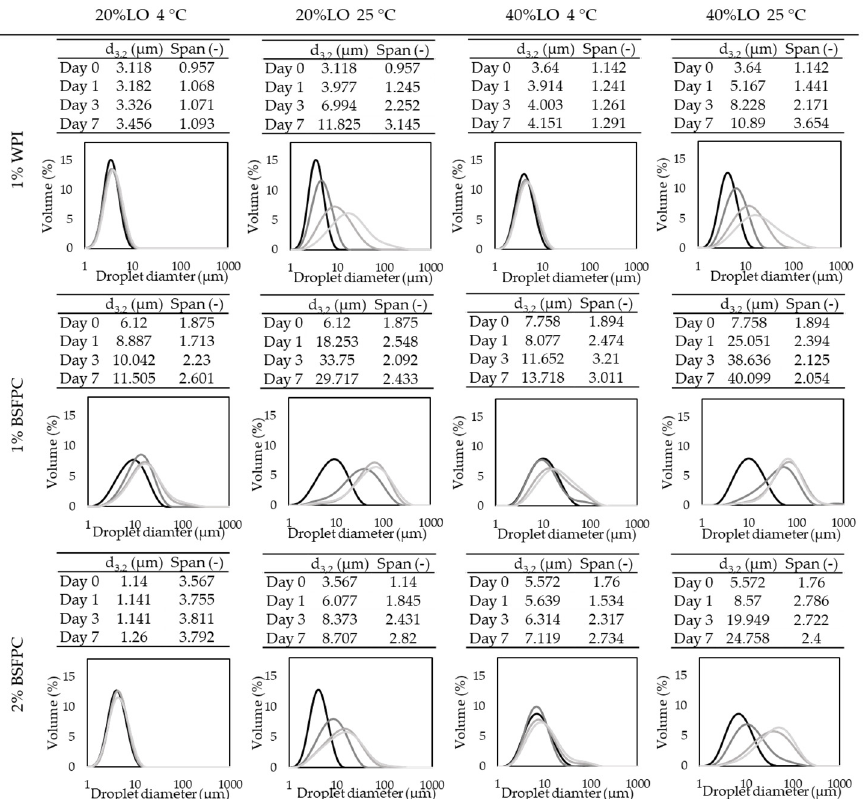
Figure 11. Particle size distribution of LO (lemon oil) emulsions stabilized by buffered 1% WPI (whey protein isolate), buffered 1% BSFPC (black soldier fly protein concentrate), and buffered 2% BSFPC after day 0 fresh emulsion, day 1, day 3, and day 7 of storage at room temperature (25 °C) and in fridge (4 °C). The color transparency scale indicates the length of storage time: from darkest to lightest refer fresh emulsion (day 0), day 1, day 3, and day 7.